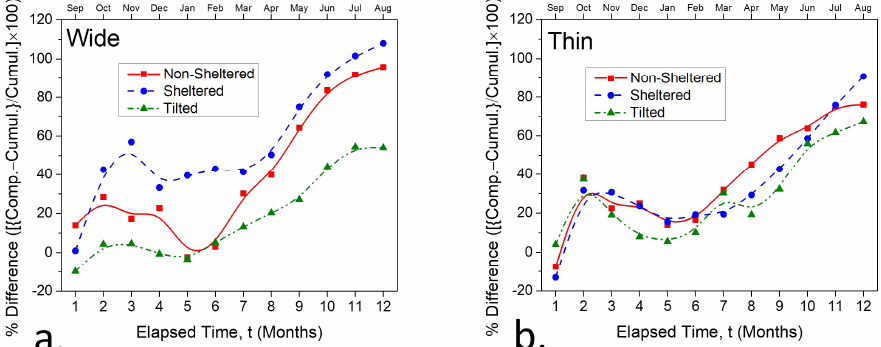
Figure 5. A comparison of mass loss between Wide and Thin samples. The cumulative mass loss for all conditions are overlaid to show the higher mass loss for Thin samples ( a ). The percent difference between the Thin and Wide samples for each condition quantifies the increased mass loss for Thin samples ( b ).